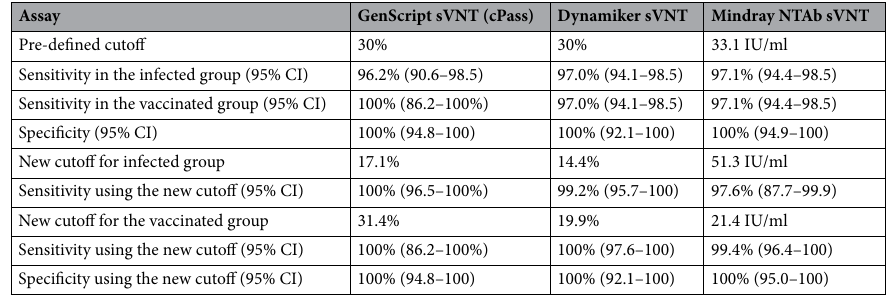
Table 2. Analytical performance of the evaluated sVNT assays using the pre-defined cutoff values and the newly calculated cutoff values determined using Youden’s